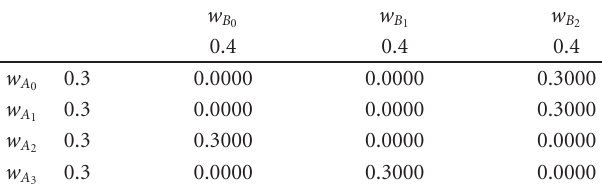
Table 5: Flow in EMD IM